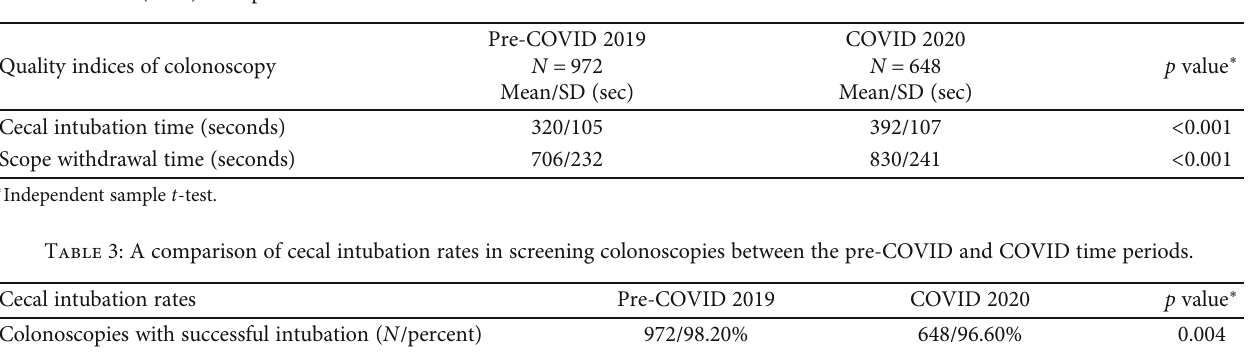
Table 2: A comparison of cecal intubation times and scope withdrawal times in screening colonoscopies between the pre-COVID-19 (2019) and COVID-19 (2020) time periods.